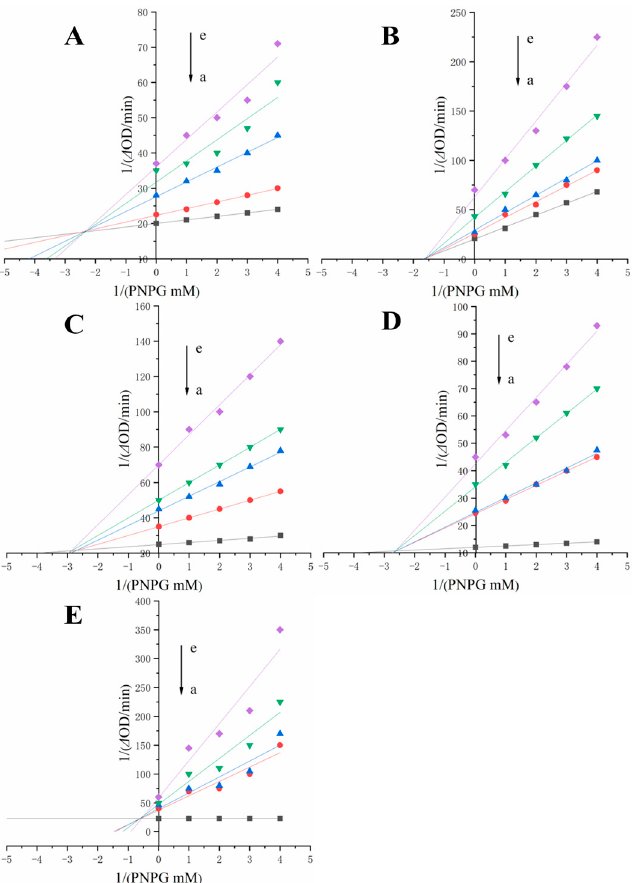
Figure 1. Lineweaver–Burk plot of different inhibitors against α -glucosidase. ( A ), RU, a–e concentrations were 0, 0.33, 0.66, 1.3, 2.6 mM; ( B ), QU, a–e concentrations were 0, 0.33, 0.66, 1.3, 2.6 mM, respectively; ( C ), HY, a–e concentrations were 0, 0.33, 0.66, 1.3, 2.6 mM; ( D ), QI, a–e concentrations were 0, 0.33, 0.66, 1.3, 2.6 mM; ( E ), KA, a–e concentrations were 0, 0.33, 0.66, 1.3, 2.6 mM.RU represents rutin, QU represents quercetin, HY represents hyperoside, QI represents quercitrin, KA represents, kaempferol.